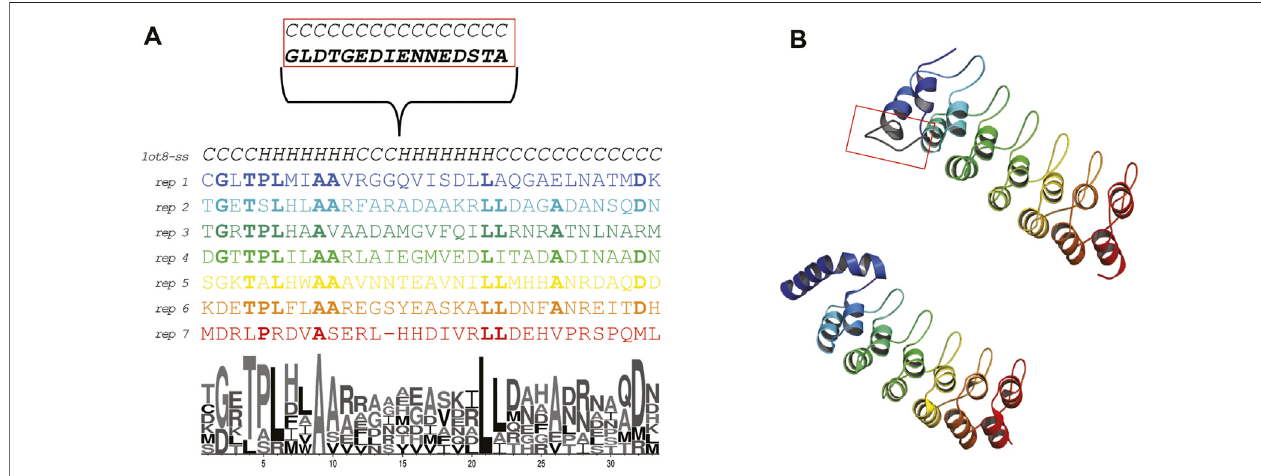
FIGURE 1 | Sequence and structure of the Ankyrin Domain of the Drosophila Notch Receptor (Uniprot P07207; PDB: 1ot8). (A) Alignment of the repeats forming the Ankyrin repeat protein studied in this work. The secondary structure content is indicated. The fi rst repeat displays an insertion that is involved in protein binding (biological native protein function). A LOGO representation is shown to highlight the residue conservation of the repeats. (B) X-ray crystal structure colored by repeat (bottom) and ab initio model (top). The conformation of the fi rst repeat in the crystal structure seems to be different than the rest of the repeats (probably due to a crystallization artifact, 26 ATOM records are missing in all chains). Due to the relevance of the repeats for this work, we ab initio modeled the protein using the